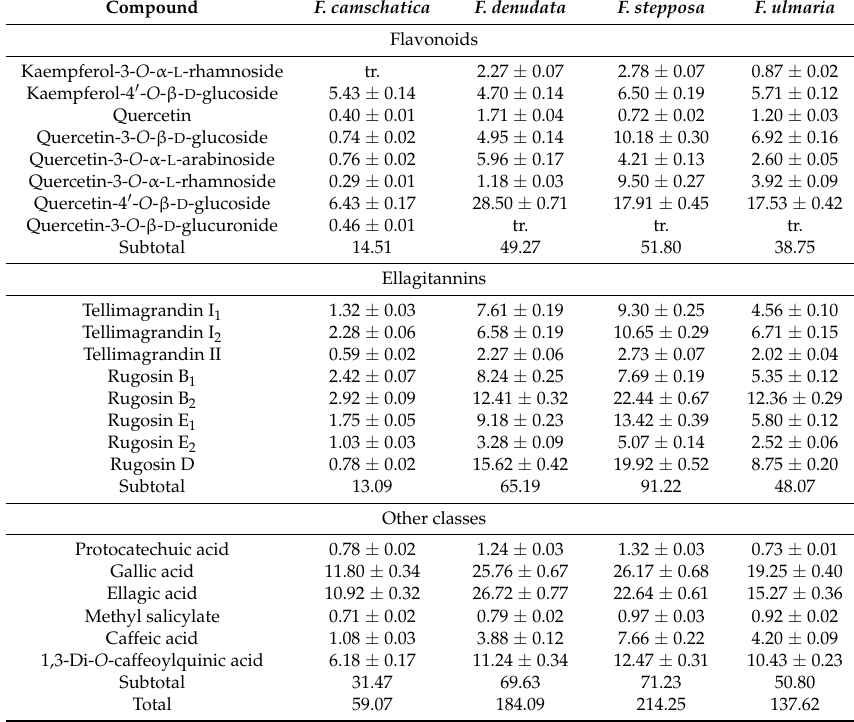
tr.—traces amounts (<limit of